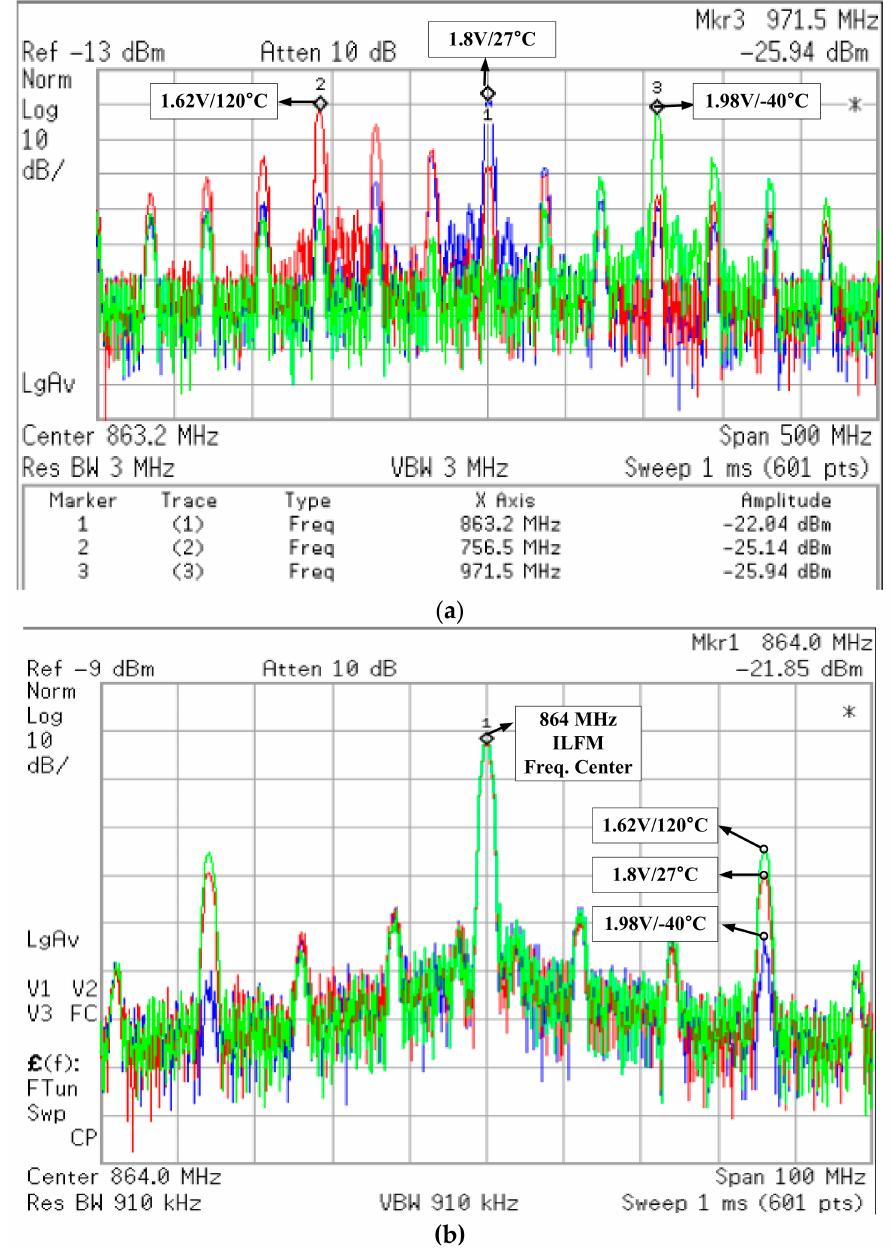
Figure 13. The measurement result of ILFM Frequency calibration ( a ) before calibration and ( b ) after